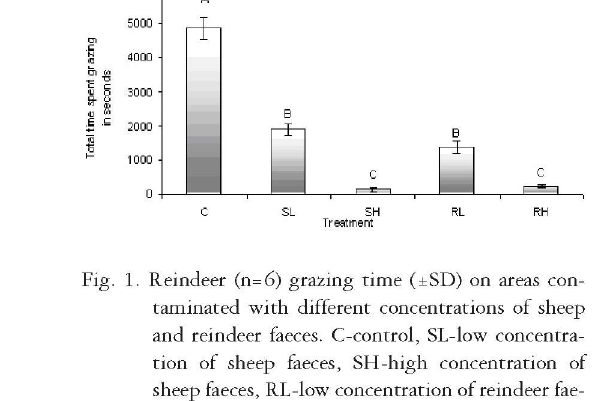
Fig. 1. Reindeer (n=6) grazing time (±SD) on areas con¬ taminated with different concentrations of sheep and reindeer faeces. C-control, SL-low concentra¬ tion of sheep faeces, SH-high concentration of sheep faeces, RL-low concentration of reindeer fae¬ ces, RH-high concentration of reindeer faeces. Columns with the same capital letter are not sig¬ nificantly different (ANOVA on ranks followed by Student-Newman-Keuls multiple comparison method,